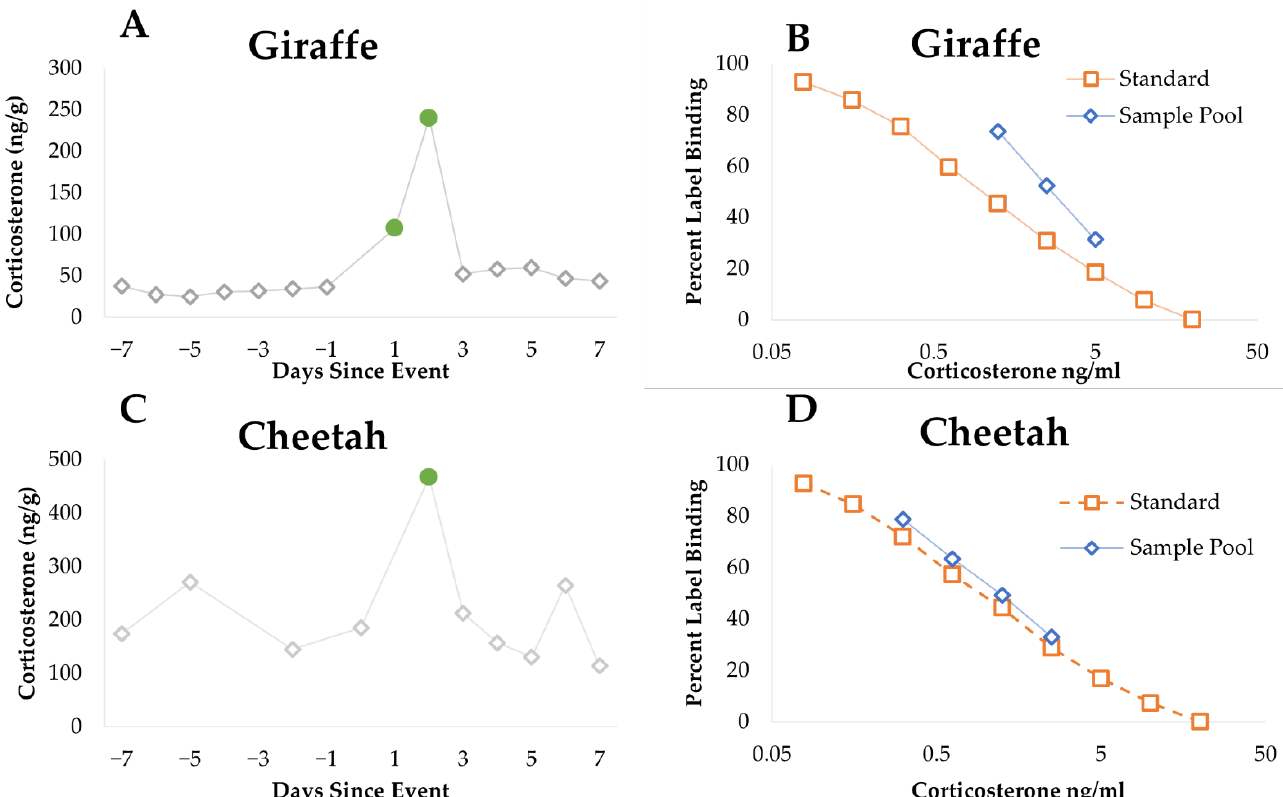
Figure 1. Endocrinology validation data for giraffes and cheetahs. ( A ) Biological validation of giraffes displaying significant peaks post-institution transfer. ( B ) Parallelism for giraffes of pooled samples and standards using antibody “CJM006”. ( C ) Biological validation of cheetahs displaying a significant peak post-surgery. ( D ) Parallelism for cheetahs of pooled samples and standards using antibody “CJM006”. Highlighted ( ● ) data points are >2 standard deviations above the calculated baseline for each individual.